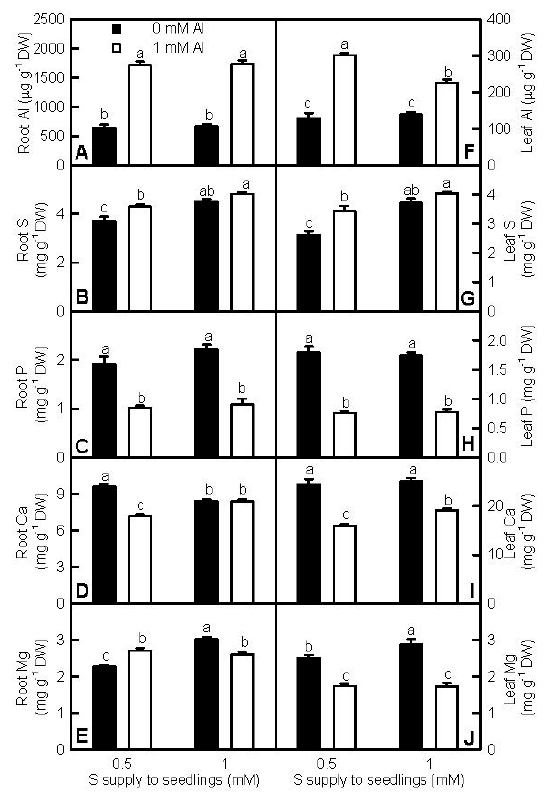
Figure 2. Effects of S and Al interactions on Al ( A , F ), S ( B , G ), P ( C , H ), Ca ( D , I ), and Mg ( E , J ) concentrations in roots ( A – E ) and leaves ( F – J ). Bars represent means ± SE ( n = 4–8). Differences among the four treatments were analyzed by two (Al levels) × two (S levels) ANOVA. Different letters indicate a significant difference at p < 0.05.